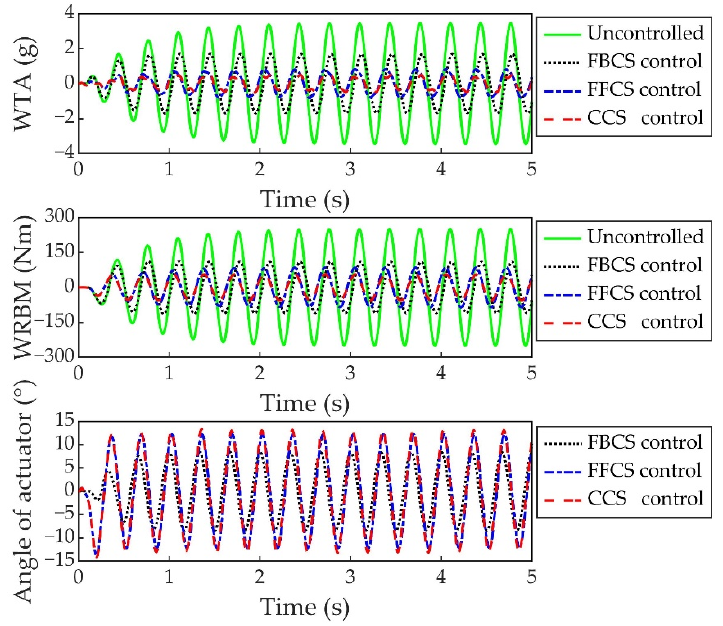
Figure 10. Comparison of gust alleviation effects of sine gust.